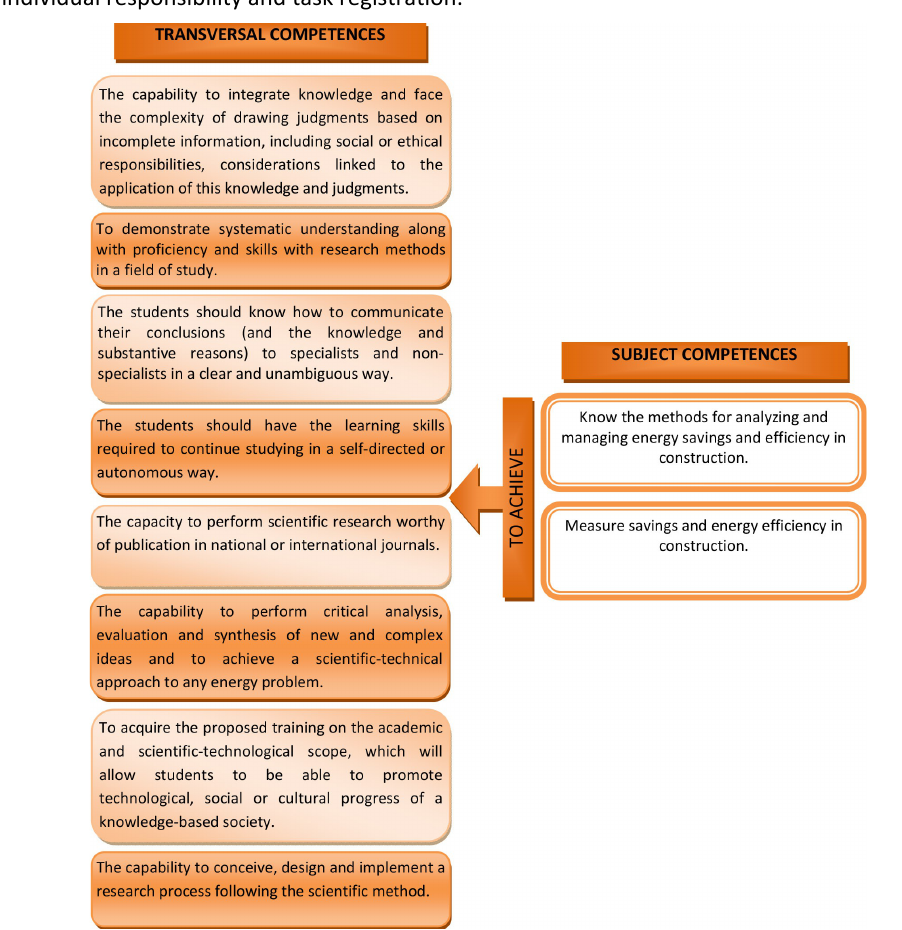
Figure 1. Transversal and specific competences that will be developed